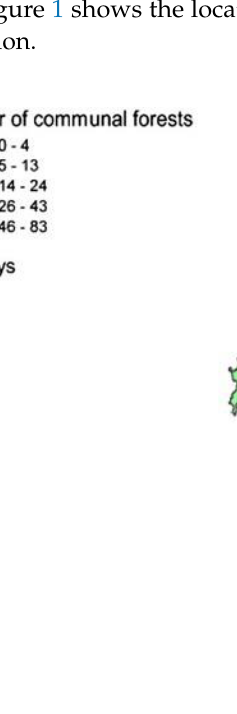
Figure 1. Location of communal forests in Galicia. Source: Fourth National Forest Inventory, Spanish Ministry of Agriculture, Fisheries and Food (2010).